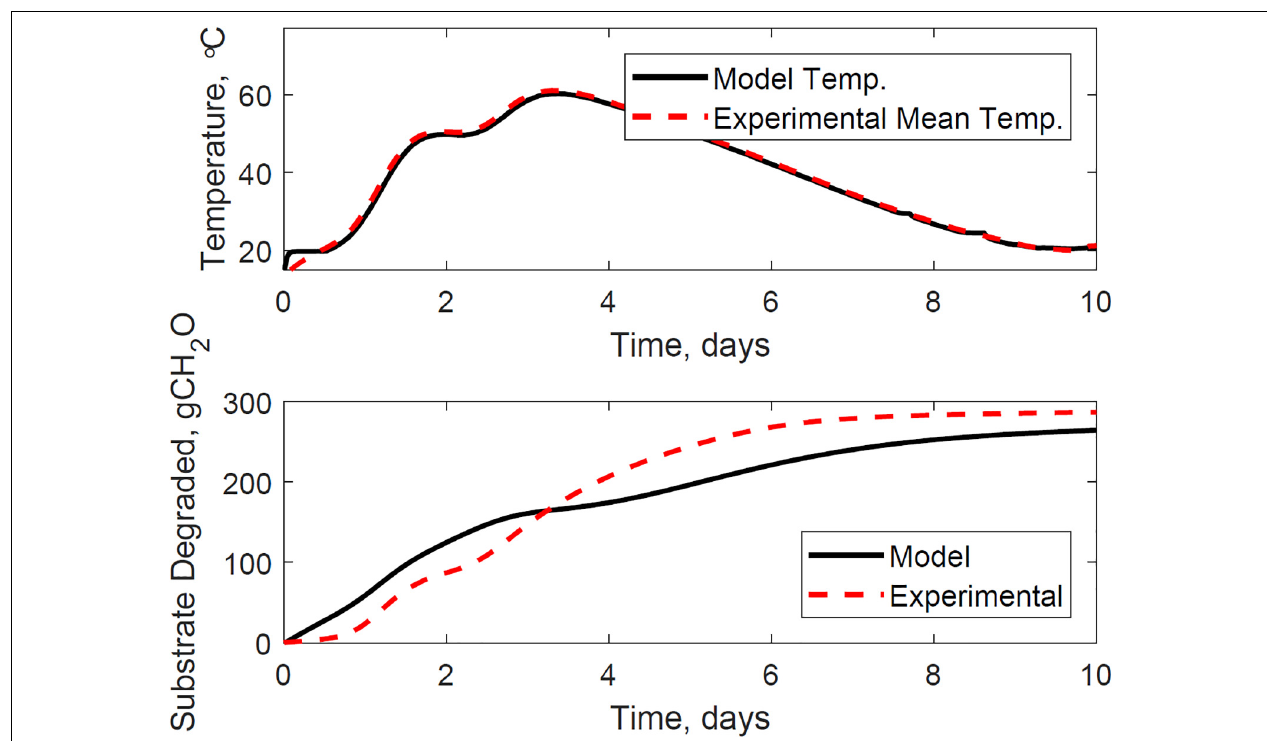
FIGURE 11 | Reactor 4 temperature (top) and substrate degraded (bottom) validation of system dynamics model. The model inputs are 1209 cc.min − 1 airflow rates, 29% initial moisture content, 18% final moisture content, 24 ◦ C ambient temperature. The initial model conditions are 13.5 ◦ C and 7290 g. The temperature mean absolute error is 0.8 ◦ C, and the dry matter loss relative error is